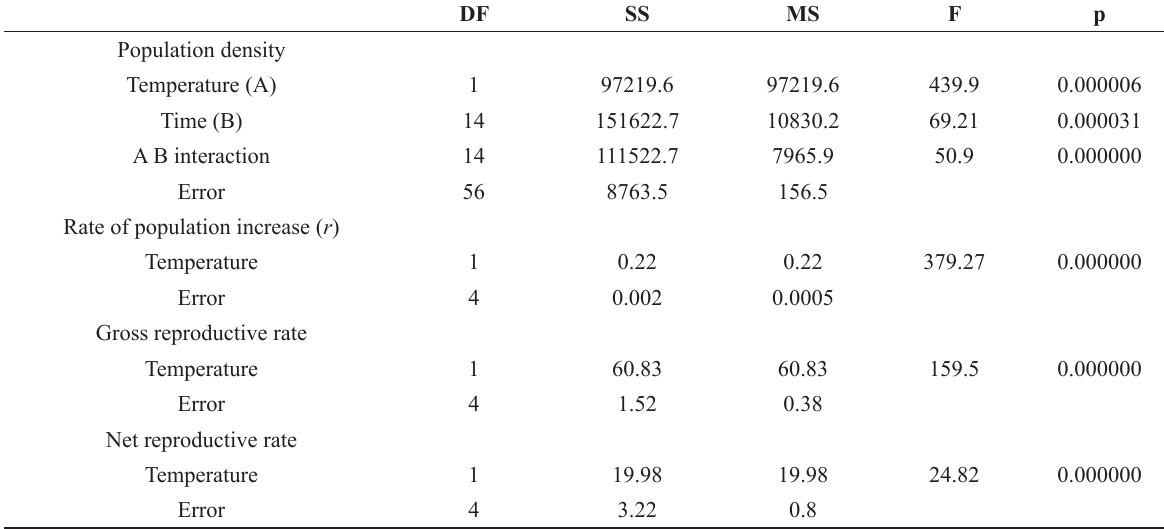
Statistical evaluation by RM ANOVA of the population density of Brachionus plicatilis and by one-way ANOVA of the gross and net reproduction rates and the rate of increase in the population of Brachionus plicatilis at